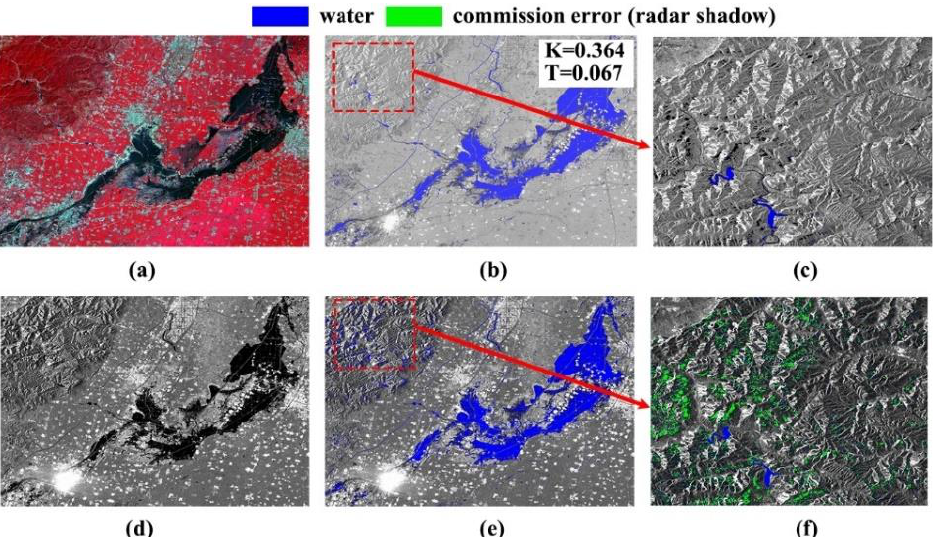
Figure 12. Waterbody extraction map for Xunxian County, Henan Province, under radar shadow interference: ( a ) Optical image. ( b ) Water extraction based on the SOWI. ( c ) Partially enlarged view of the SOWI water extraction results. ( d ) SAR image. ( e ) Water extraction based on HH. ( f ) Partially enlarged view of the HH water extraction.